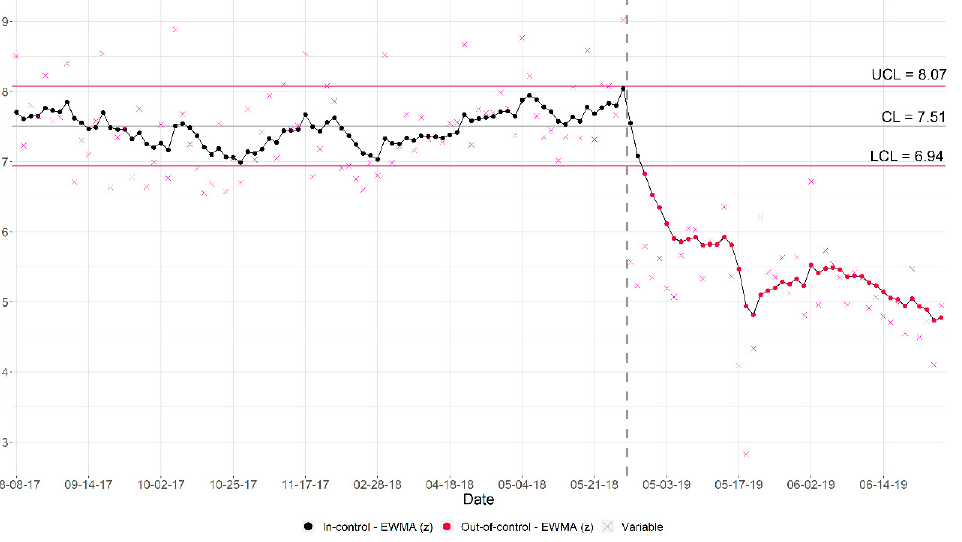
Figure 6. EWMA Control Chart—Average volume per flush per day.